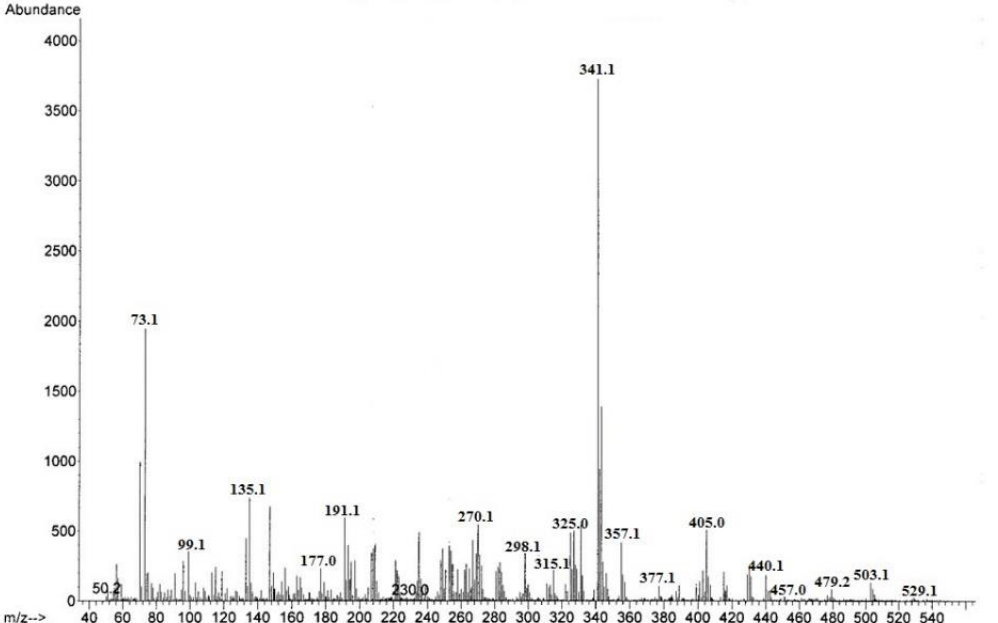
Рис. 5. Мас-спектр сертиндолу, ізольованого із тканин печінки